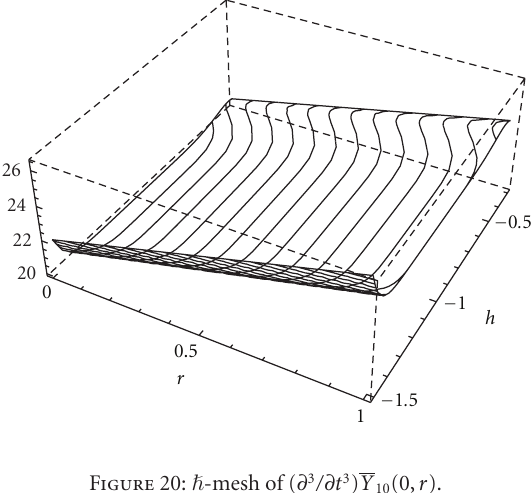
Figure 20: (cid:2) -mesh of ( ∂ 3 /∂t 3 ) Y 10 (0, r ).